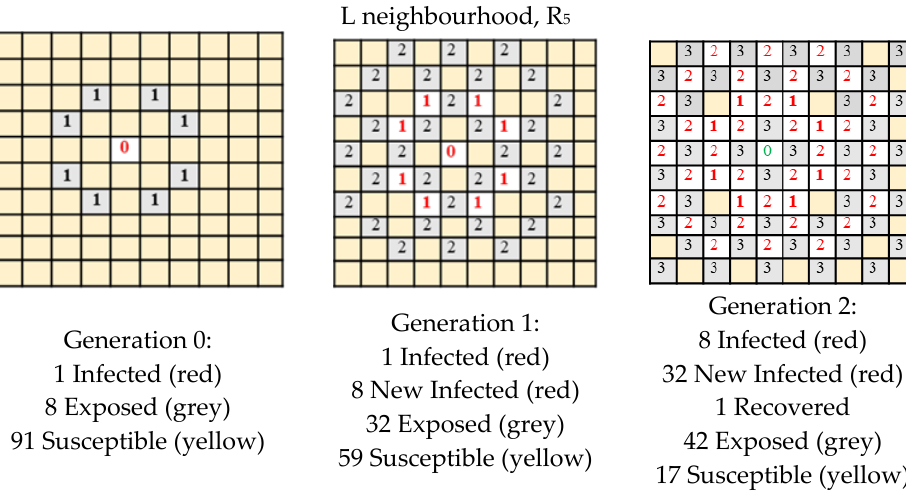
Figure 6. Expansion schedule shown for the three first generations (L neighbourhood) .